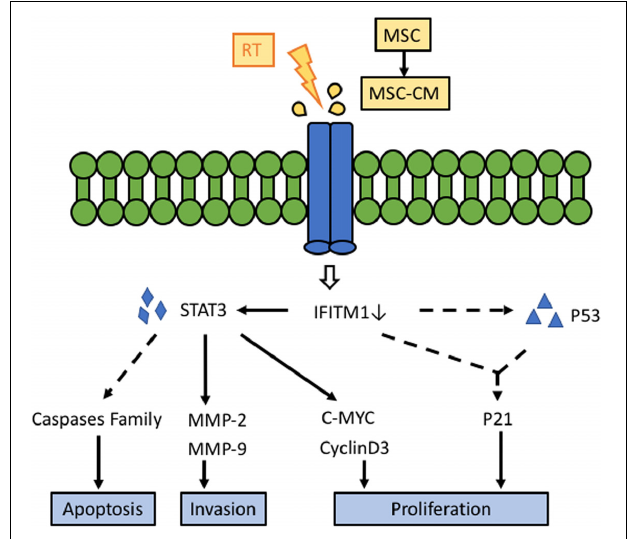
FIGURE 8 | Schematic diagram of the potential effect of the RT and AT-MSCs combination therapy on HCC. Our results suggest that the synergistic treatment effect of RT and AT-MSCs has therapeutic potential for HCC in mice via the inhibition of IFITM1 expression, inhibition of HCC cell proliferation via upregulation of p53 and p21, inhibition of tumor invasion via downregulation of MMPs, and promotion of HCC cell apoptosis. AT-MSCs: adipose tissue-derived mesenchymal stem cells; AT-CM: conditioned medium (CM) from AT-MSCs; IFITM1: interferon-induced transmembrane protein 1; STAT3: signal transducer and activator of transcription 3; MMP: matrix